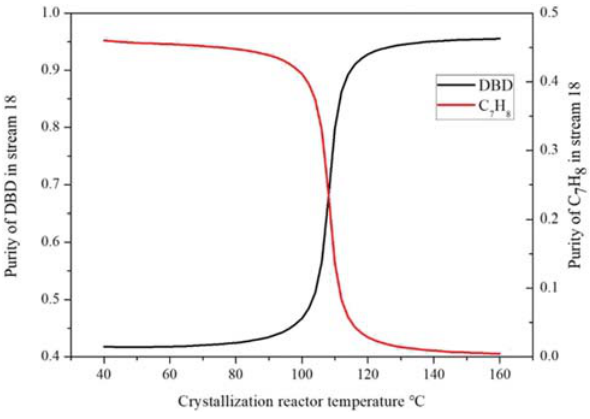
Figure 11: Relationship between the crystallizer temperature and the purity of the DBD and the C 7 H 8 in stream